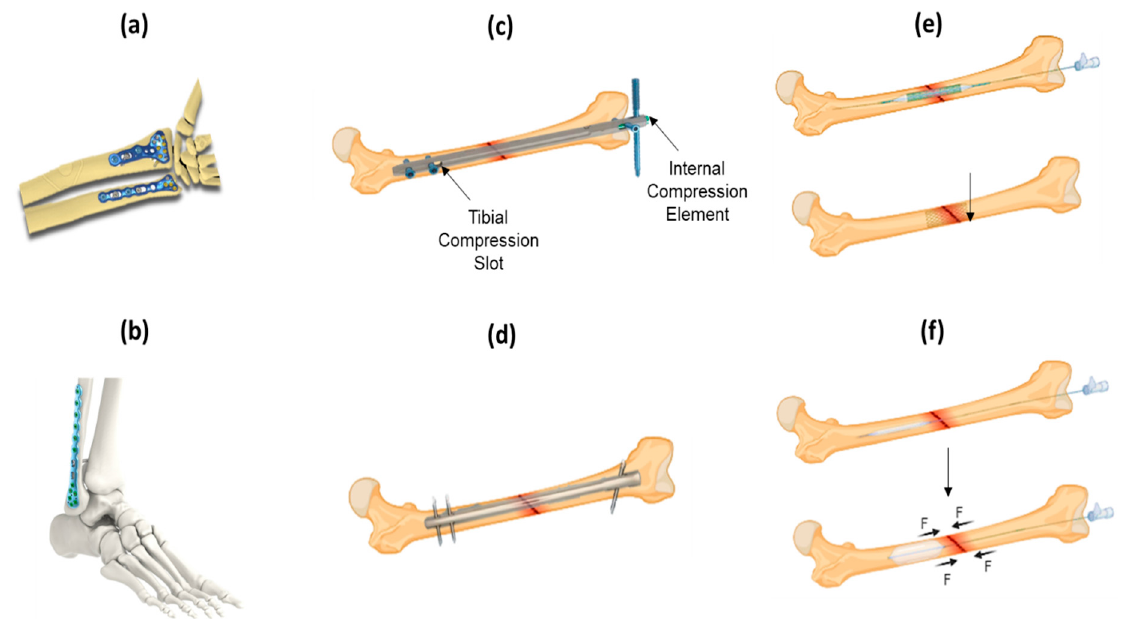
Figure 4. Internal fixation devices such as ( a ) dynamic compression plates for ulna and radius and ( b ) ankle bone fractures, including screws for the bone stabilisation, ( c ) intramedullary compression nail, ( d ) interlocking nail, ( e ) metallic stent to the fracture site “bridge” and ( f ) balloon application to the fracture site.